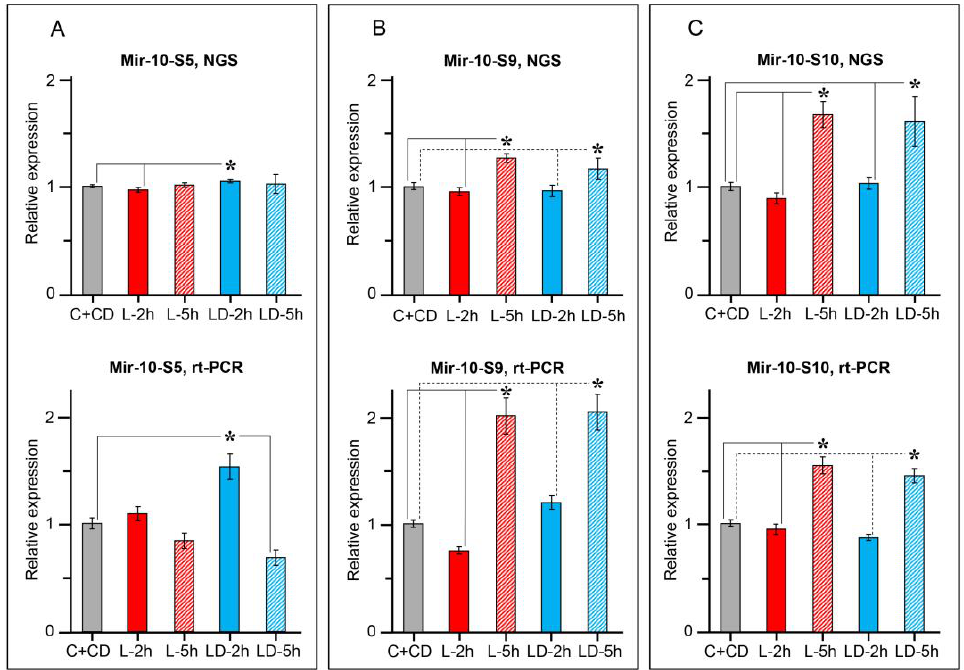
Figure 6. MicroRNAs of the MIR-10 superfamily regulated in the CNS of H. lucorum after training. ( A ) Mir-10-S5, ( B ) Mir-10-S9, ( C ) Mir-10-S10. The results of next-generation sequencing (NGS) were confirmed by real time PCR. Experimental groups and the number of independent samples in sequencing/PCR analyses are as follows: naïve normal (5/7); naïve DHT-treated (5/6); 2 h post-training, normal (6/7); 2 h post-training, DHT-treated (6/8); 5 h post-training, normal (3/9); 5 h post-training, DHT-treated (3/6). C+CD -general control groups of naïve animals, normal, and DHT treated; L-2 h/5 h and LD-2 h/5 h — trained animals, normal (L) or DHT treated (LD), 2 or 5 h after training. Data are presented as “mean ± SEM”. * p < 0.05.